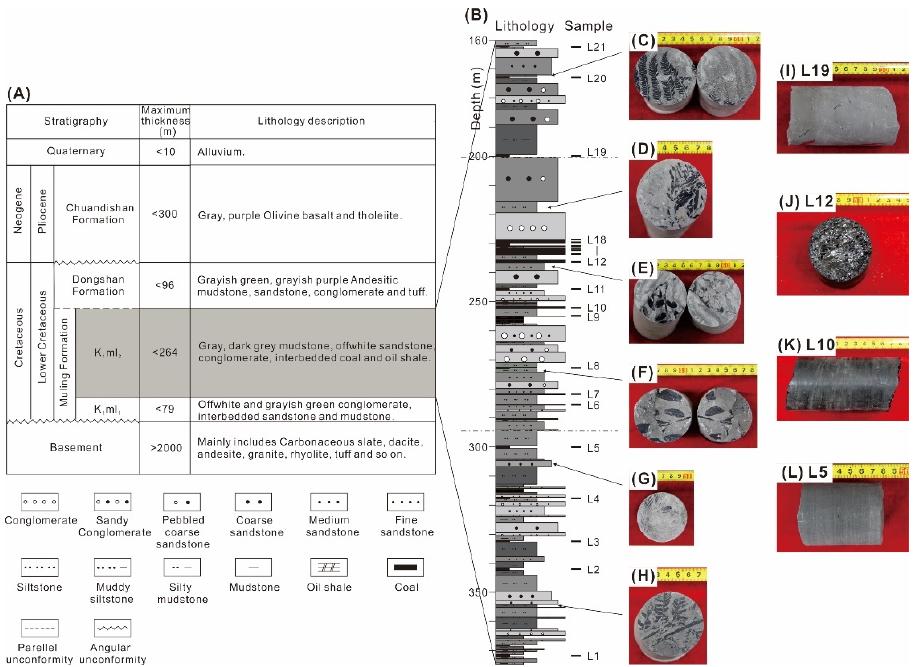
Figure 2. ( A ) Stratigraphic subdivision of the Laoheishan Basin [28], the studied interval is marked with grey shading. ( B ) Lithology and sampling depth in the N1. Two horizontal grey lines show the boundaries of three units. Plant fossils observed in the N1: ( C , G , H ) Ferns. ( D , E , F ) Gymnosperms (probably conifers). Macroscopical photos of the studied oil shale ( I , L ) and coal ( J , K ) samples.